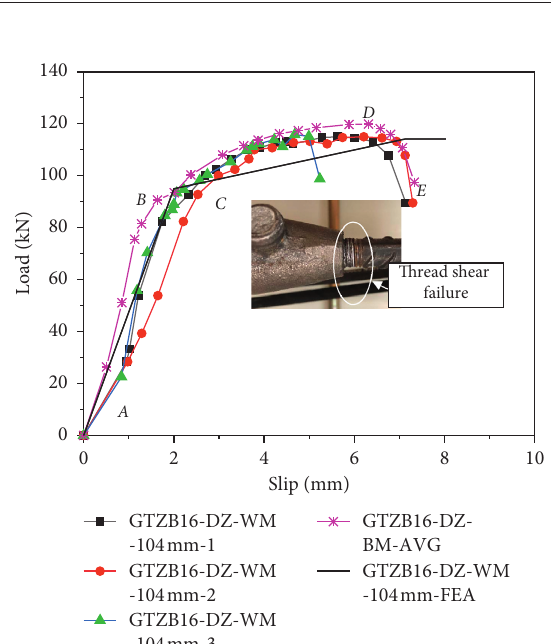
Figure 9: The load-slip curves of insufficient grout height specimen (104mm: 6.5d; AVG: average value; FEA: finite element